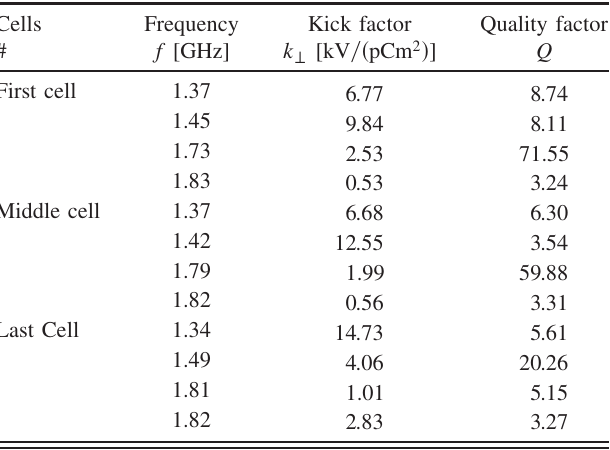
TABLE I. Scaled long-range transverse wakefield